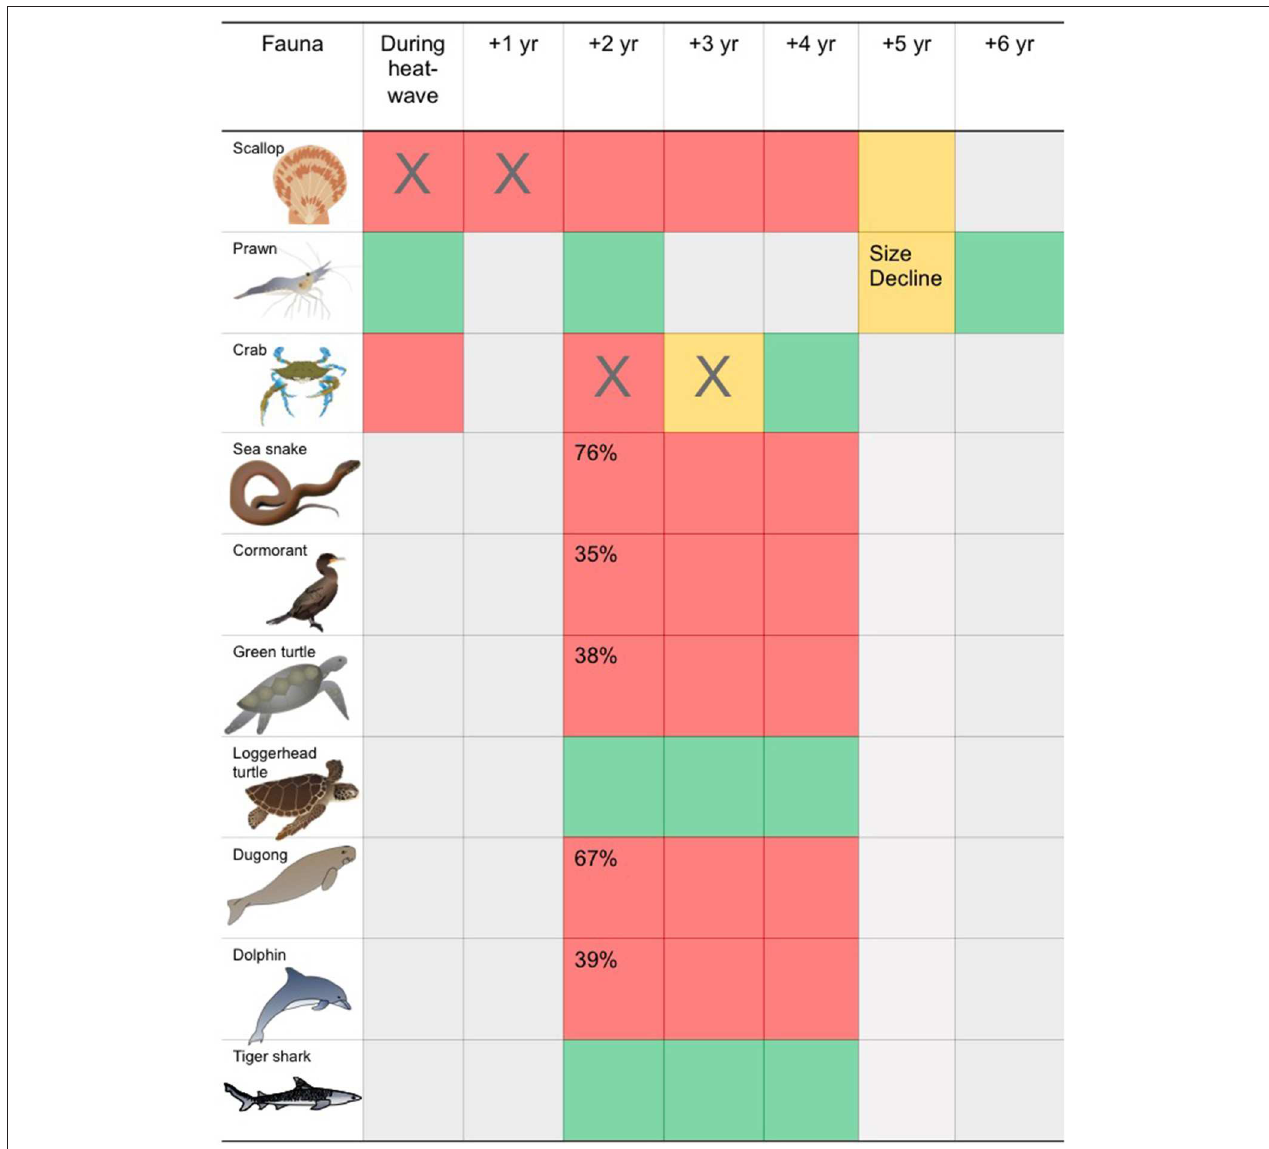
FIGURE 6 | Generalized timeline of change in seagrass associated biota before to after the 2011 heatwave. Red, population decline; Yellow, other change to population; Green, no decline in population; Gray, no data; “X”, fishery closure (see Nowicki et al., 2019 for details).